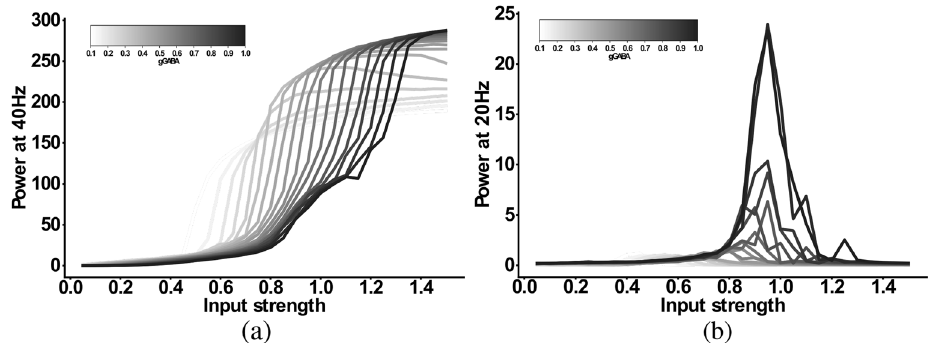
Figure 4. Input strength dependence of the 20 Hz component in the ‘IPSC+gGABA-SCZ-like’ model. ( a ) Power at 40 Hz in response to 40 Hz drive as a function of the input strength. ( b ) Power at 20 Hz in response to 40 Hz drive as a function of the input strength. In both plots the network model has increased IPSC decay times (from 8 to 28 ms) and the I-E and I-I synaptic strength ( g ie and g ii , respectively) is varied from 100% (black) to 10% (lightest grey) in steps of 5%.